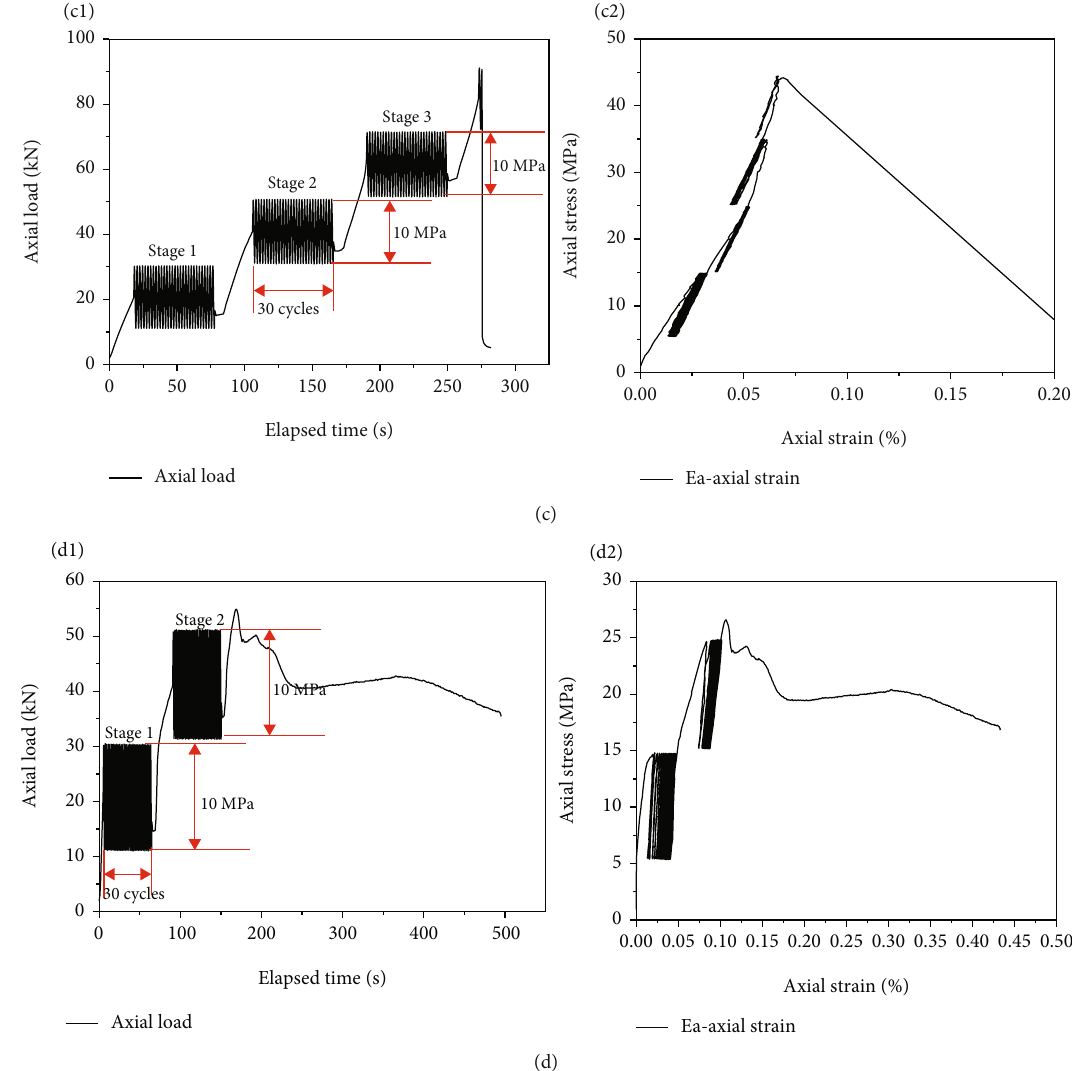
Figure 3: The loading path and axial stress-strain curves for the granite samples with natural fractures. (a – d) The natural fracture volume ratio is 0.08%, 0.12%, 0.56% and 2.11%,